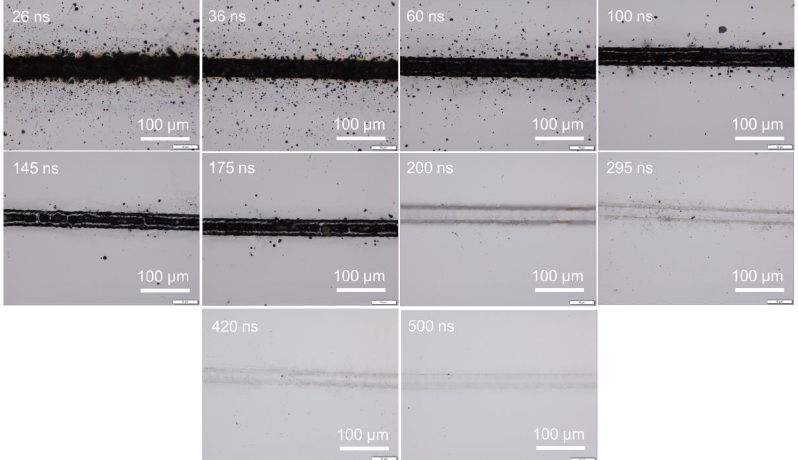
Figure 2. Optical images of irradiated silicon surfaces with 0.08 mJ pulse energy (10.24 J/cm 2 ) at a scanning speed of 50 mm/s.